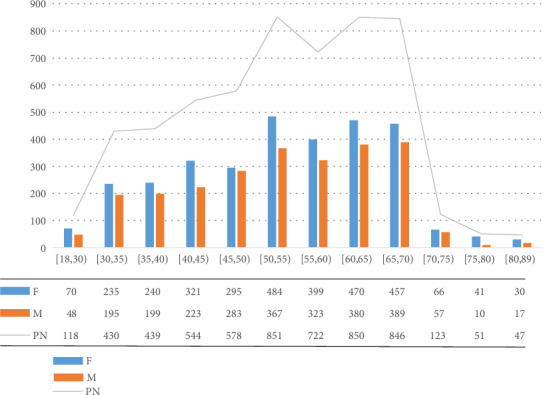
Distribution of age- and gender-based data.